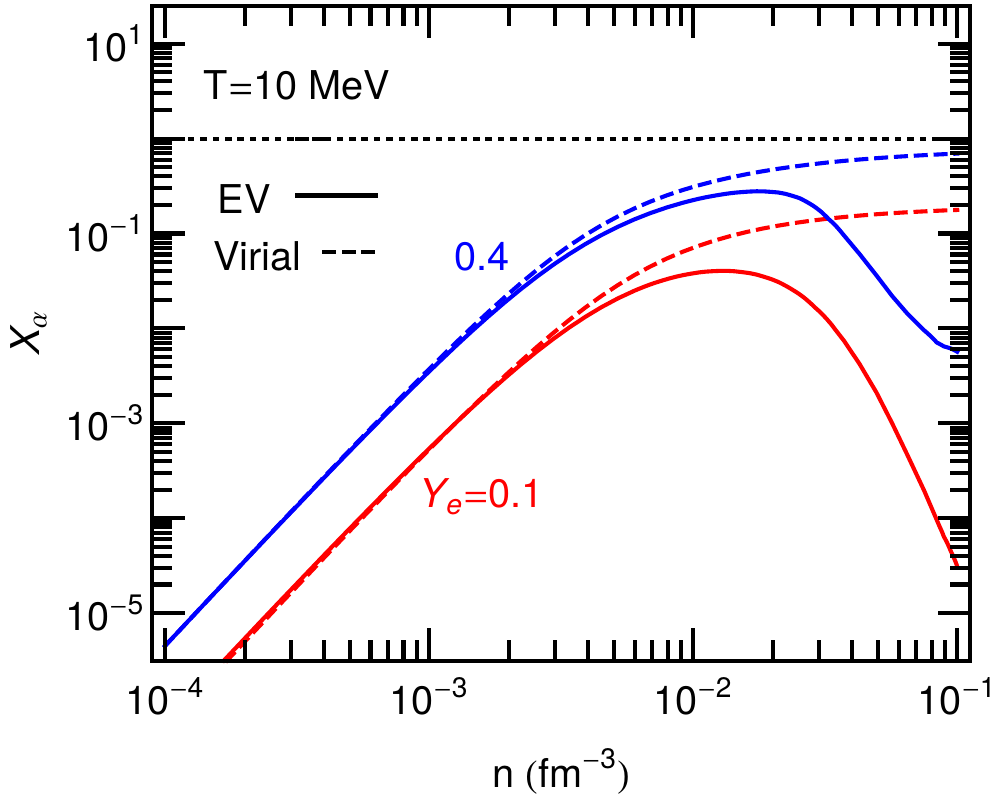
Figure 1. α -particle mass fraction X α = 4 n α / n as a function of baryon density for different electron fractions at T = 10 MeV shown for the APR/excluded volume and virial